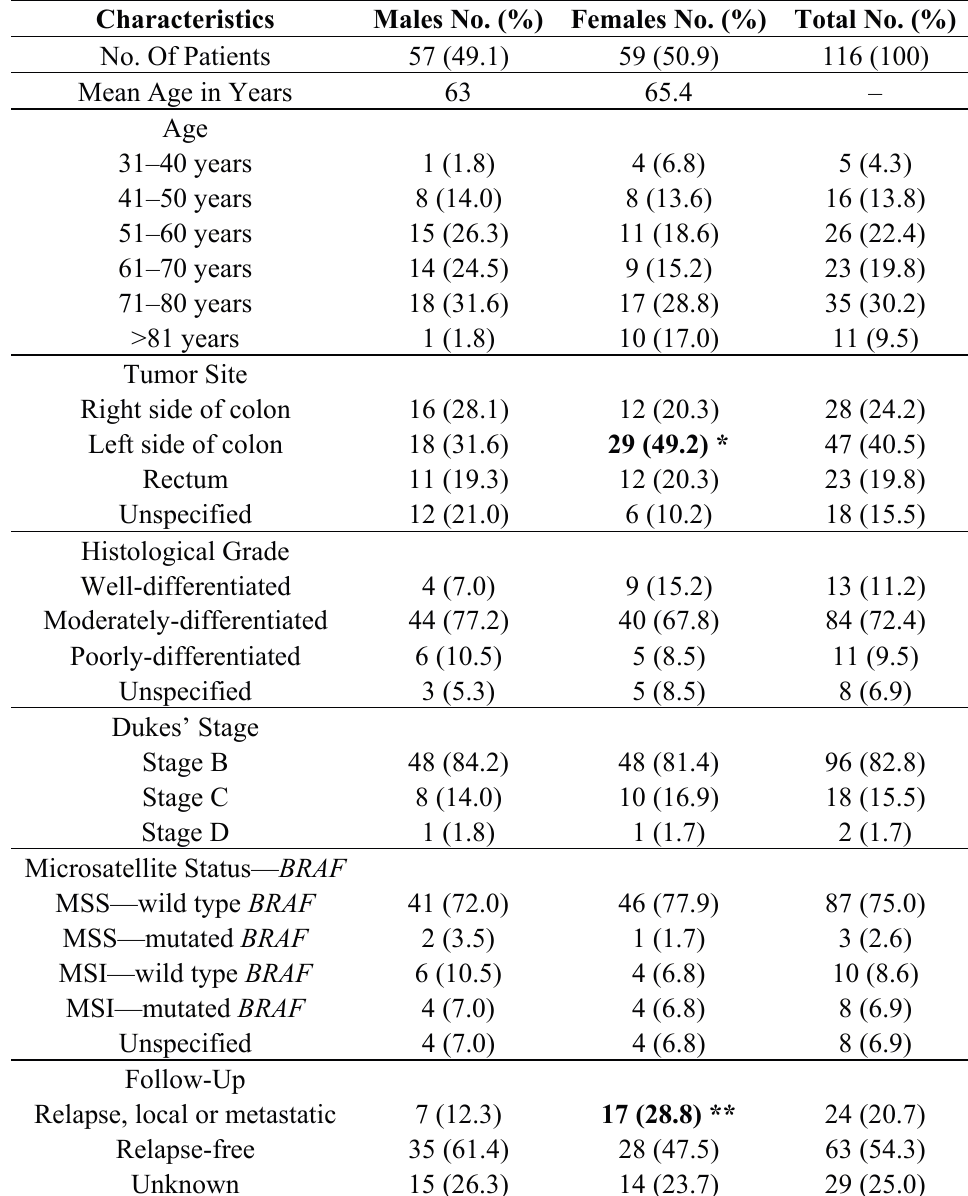
Table 1. Clinicopathological characteristics of the colorectal cancers classified based on gender.